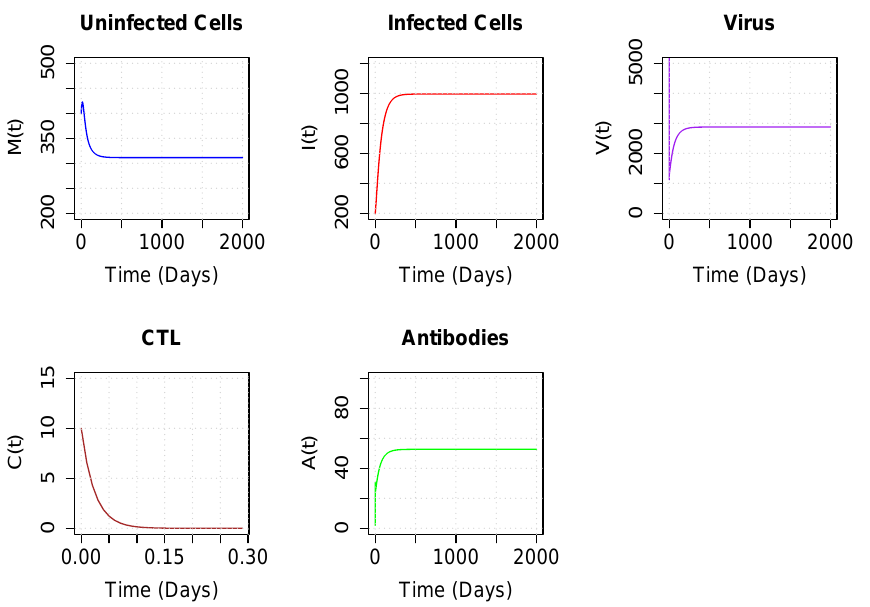
Figure 5. Trajectory plots of populations for parameters corresponding to the coexistence region below the asymptote but above the upper branch of the hyperbola. Parameter values are set to sample values of Table 1, with ψ = 0.05 and α = 1. Initial conditions are M 0 = 400, I 0 = 200, V 0 = 10,000, C 0 = 10 and A 0 = 2. Note the very brief time scale for C ( t ) .